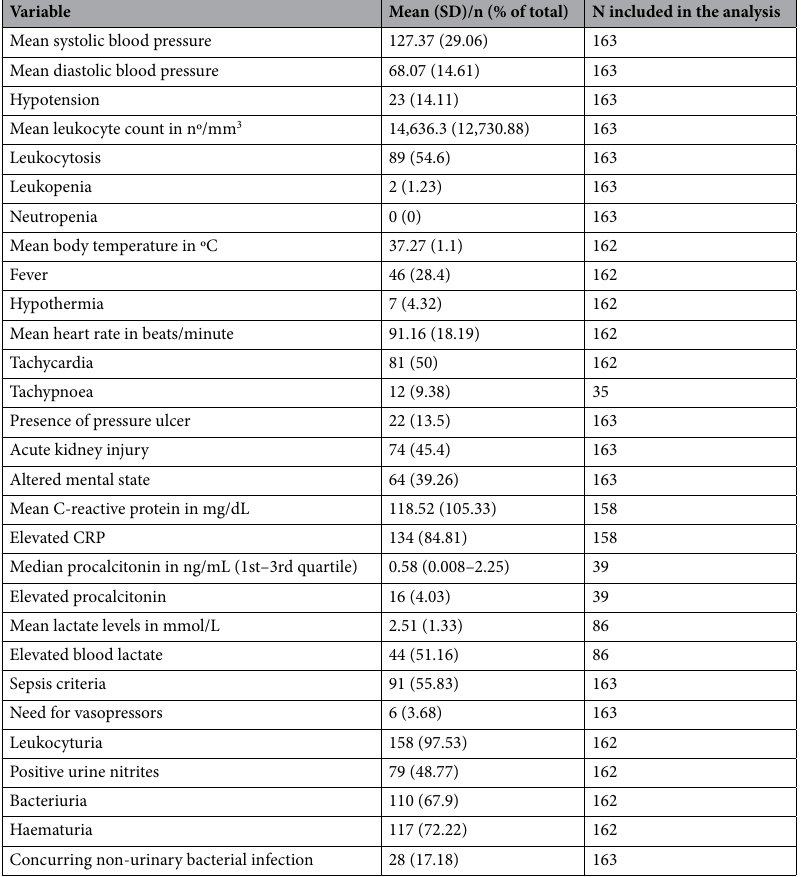
Table 2. Clinical and analytical characteristics at the time of